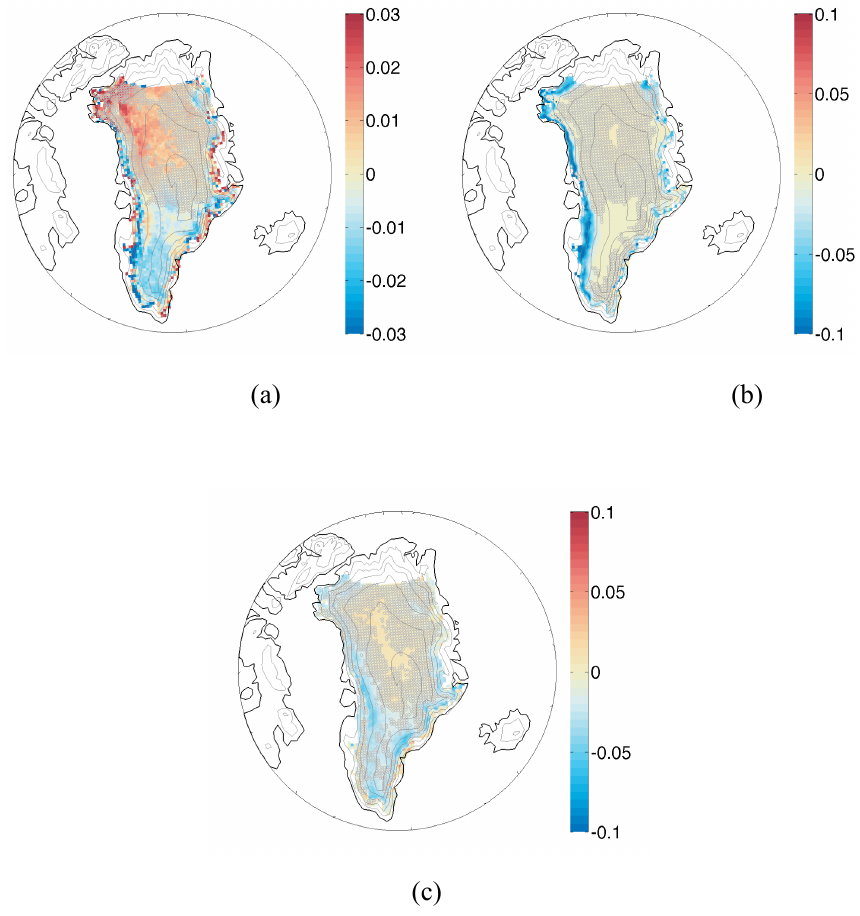
Figure 3 Figure 3. Differences between space-borne-measured and model-simulated albedo trends in different spectral regions. (a) Difference between the GLASS and MAR trends (albedo change per decade), with positive values indicating those regions where MAR trend is smaller in magnitude than GLASS. Maps of JJA mean albedo trends (1996–2012) simulated by MAR for (b) visible and (c) near-infrared wavelengths. (Fig. 2c), and the number of summer days when bare ice